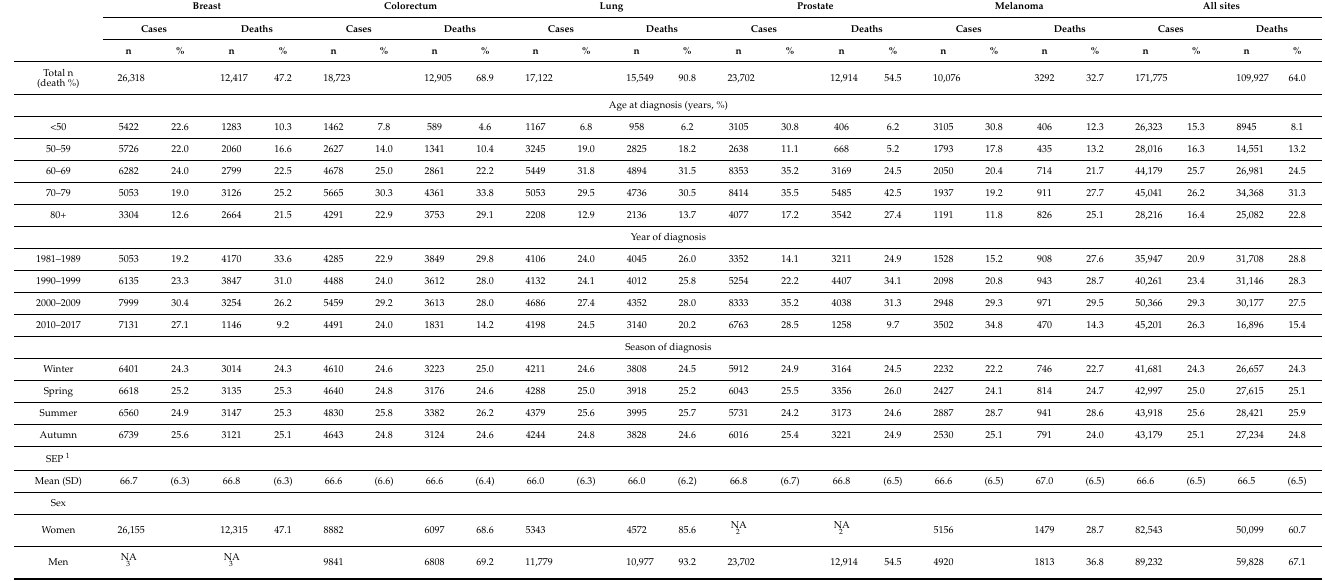
Table 1. Number of cases, deaths, and percentage distributions of available characteristics by cancer